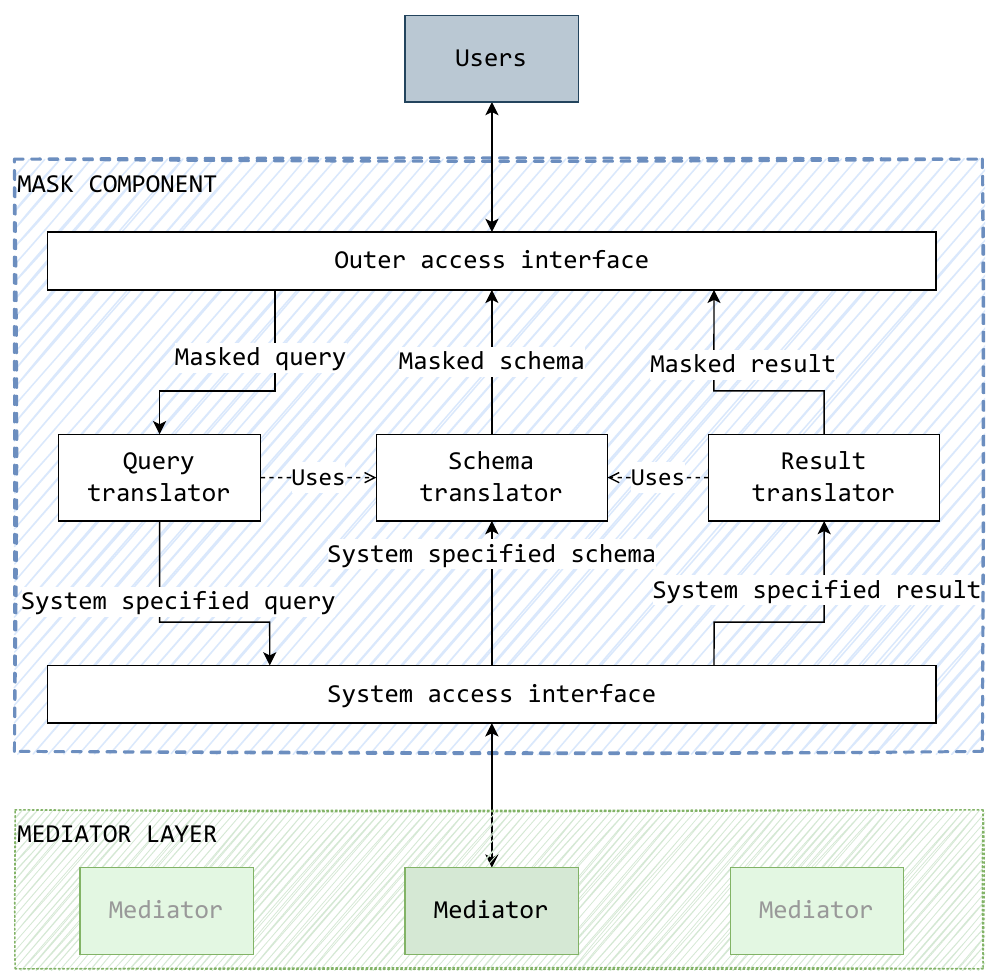
Figure 10. A conceptual model of the mask’s functional